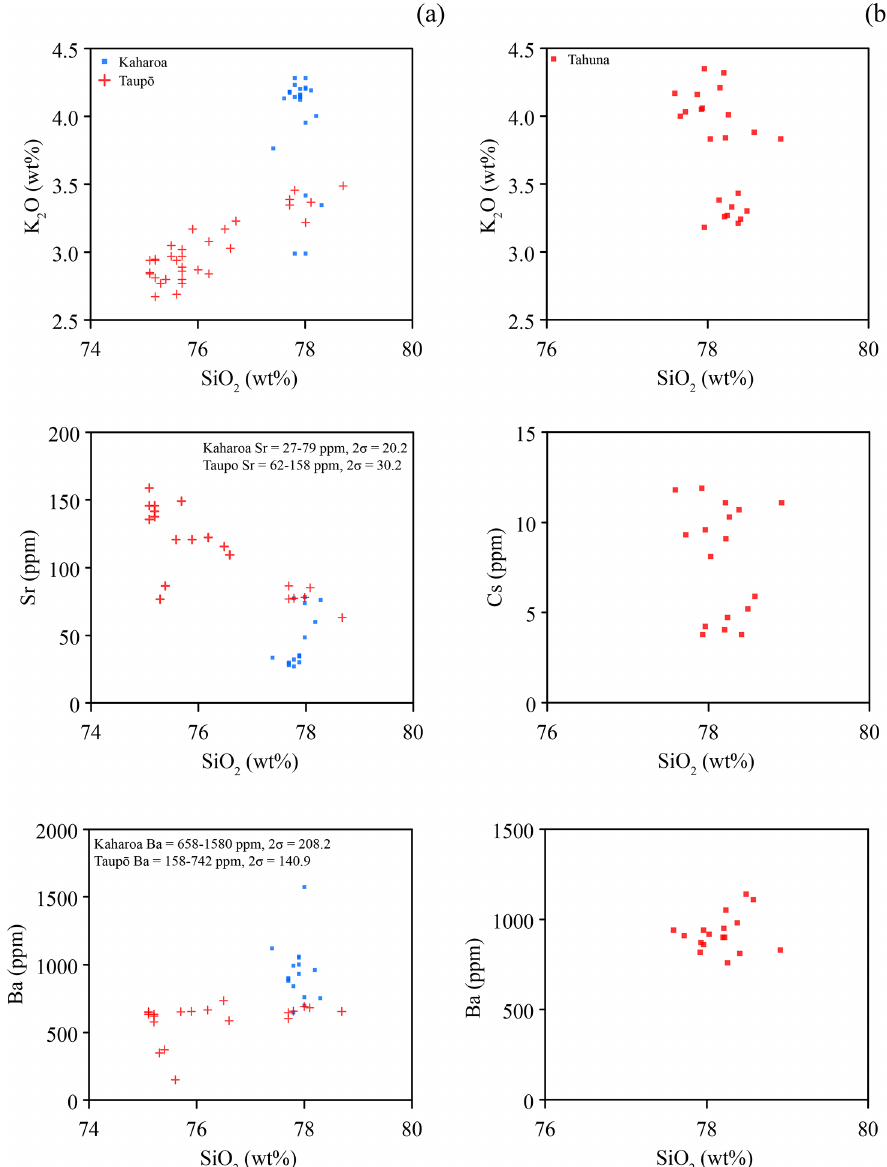
Figure 13. Biplots to show examples of how trace elements in glass enable manipulation of heterogeneous and bimodal geochemical data. Panel (a) shows analyses of glass from Kaharoa and Taup ¯ o tephras, both of which show a heterogeneous signature with most major elements (presented on a normalised basis). Sr has a low variability for Taup ¯ o but does not for Kaharoa tephra; conversely, Ba has a low variability for Kaharoa but does not for Taup ¯ o. Panel (b) shows the bimodal signature created for Tahuna tephra using K 2 O composition; this is also seen for Cs but not for